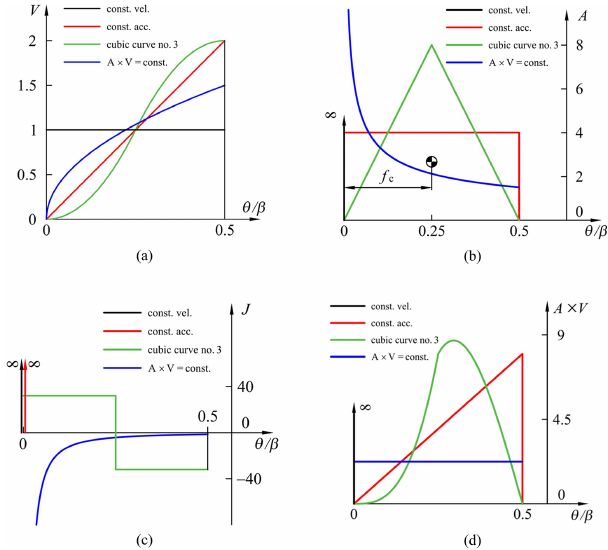
Figure 1. Normalized V , A , J , and A × V